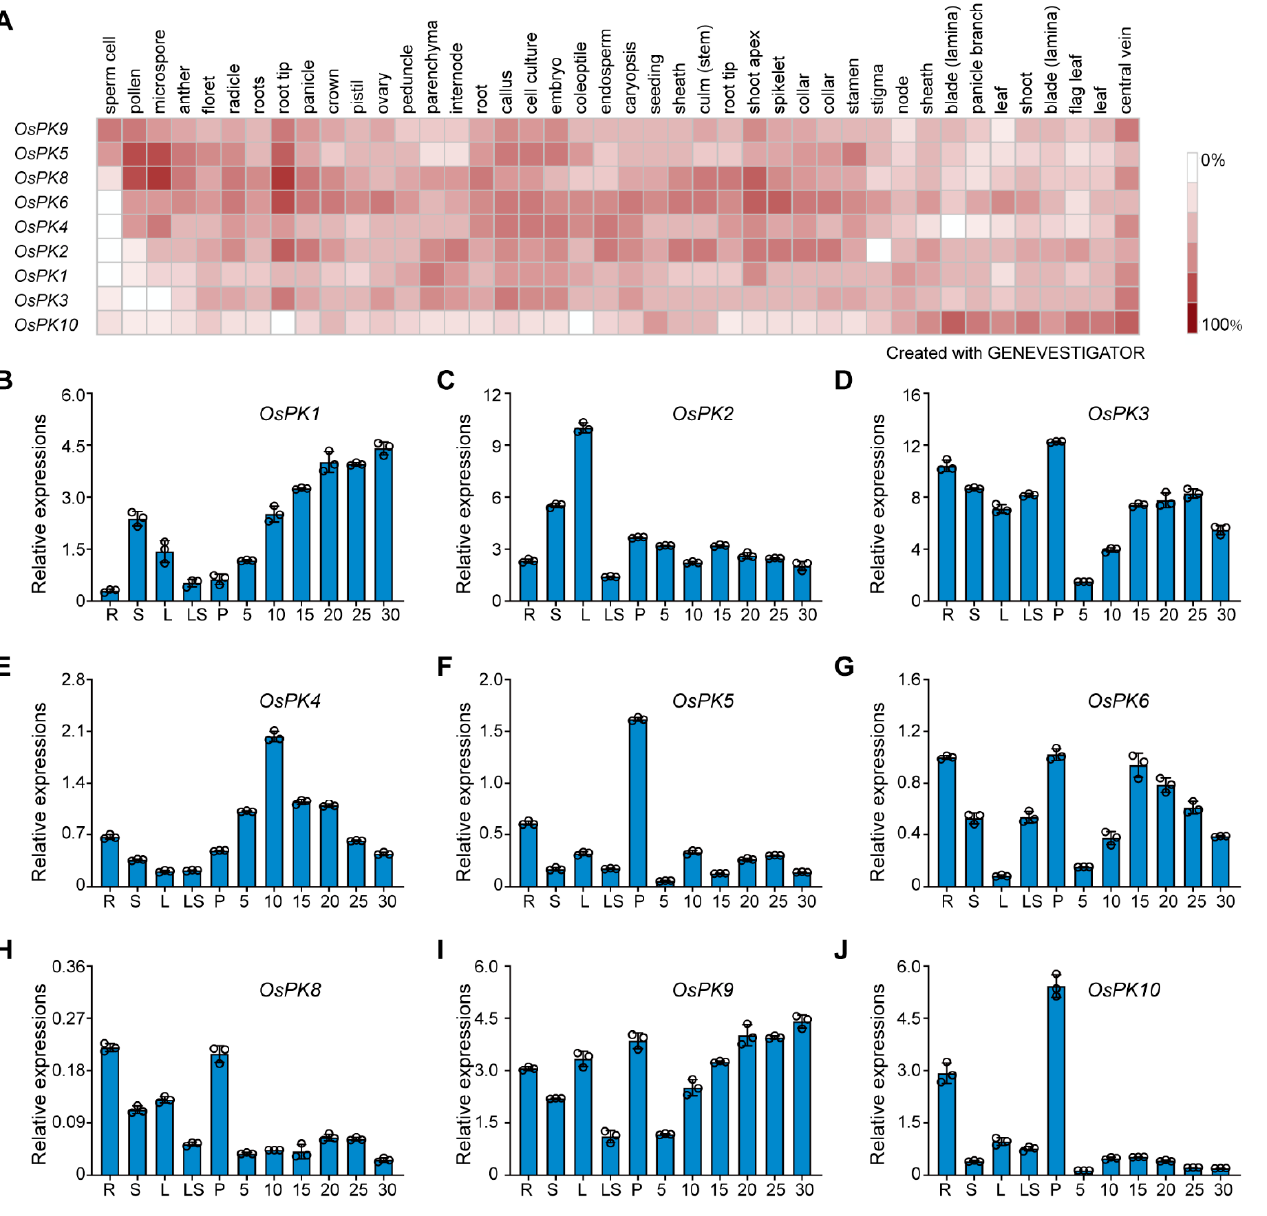
Figure 2. Expression pattern of PK genes in rice. ( A ) Heat map of expression levels of PK genes in rice. A color-based scale from red to white indicates high to low gene expression levels, respectively. ( B – J ) Relative expression level of PK genes ( OsPK1 , OsPK2 , OsPK3 , OsPK4 , OsPK5 , OsPK6 , OsPK8 , OsPK9 , and OsPK10 ) in roots (R), stems (S), leaves (L), leaf sheaths (LS), panicles (P), and seeds at 5, 10, 15, 20, and 25 days after flowering. Error bars indicate the means ± SDs of three in- dividual replicates.